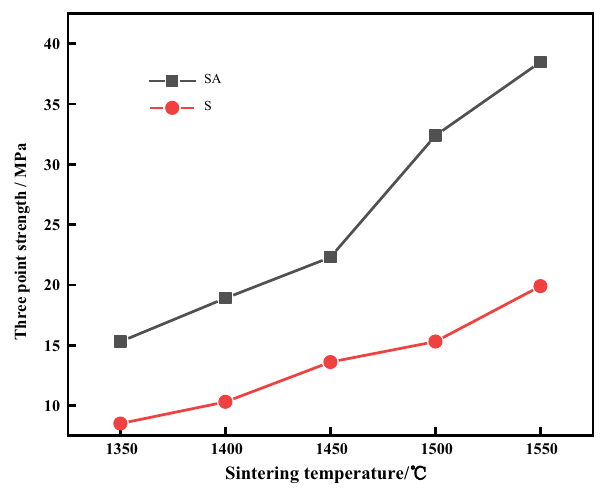
Fig.10 Strength of samples sintered at different temperatures in